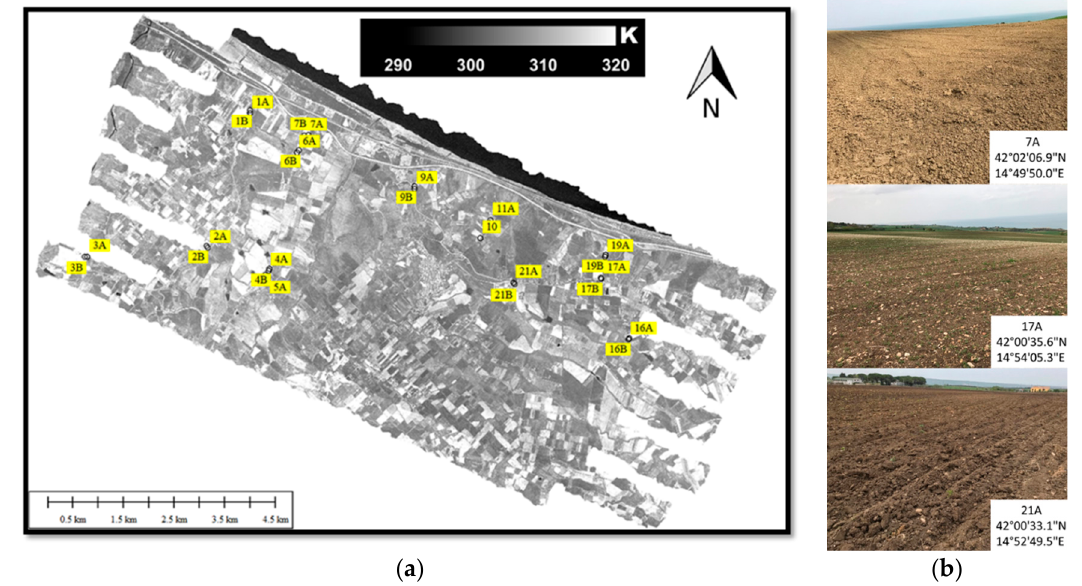
Figure 2. ( a ) TASI-600 temperature images acquired on 12 April 2018 at midday over the Petacciato study area (center coordinates: 42°00’ N; 14°51’ E), with overlapped the soil sampling points (sampling points label is indicated in the yellow boxes only for visualization purposes). ( b ) Examples of three bare/scarcely vegetated soils of agricultural fields of the study area from which the soil samples (7A, 17A, 21A) were collected for the SM and texture laboratory analysis.